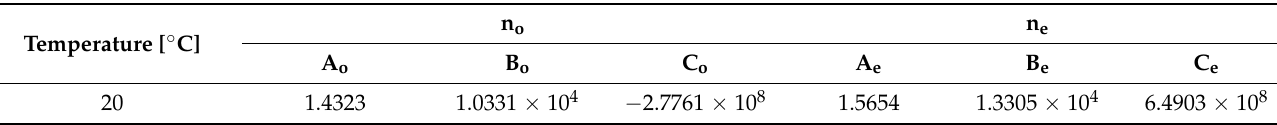
Table 2. Fitting parameters for the extended Cauchy model at 20 ◦ C using the experimental data measured at 443, 636, and 1550 nm wavelengths for multicomponent nematic mixture.